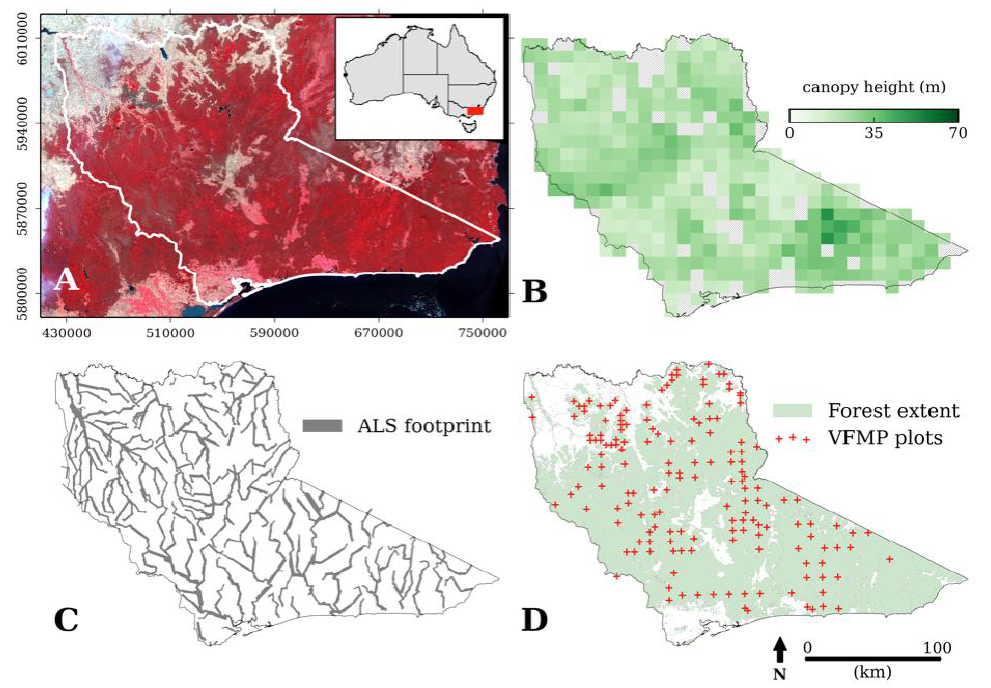
Figure 1. Study area in east Victoria, Australia. A mosaic of 5 Landsat TM false color composite images covering the study area (outlined in white) and location of the study area within Australia (inset) ( A ). Canopy height derived from ALS capture where canopy height values are aggregated into 10 × 10 km cells (grey indicates no data) ( B ). The extent of the ALS capture ( C ). Forest extent [35] and location of Victorian Forest Monitoring Programme forest inventory plots (VFMP) ( D ). Map coordinate system is the projected Map Grid of Australia (MGA) zone